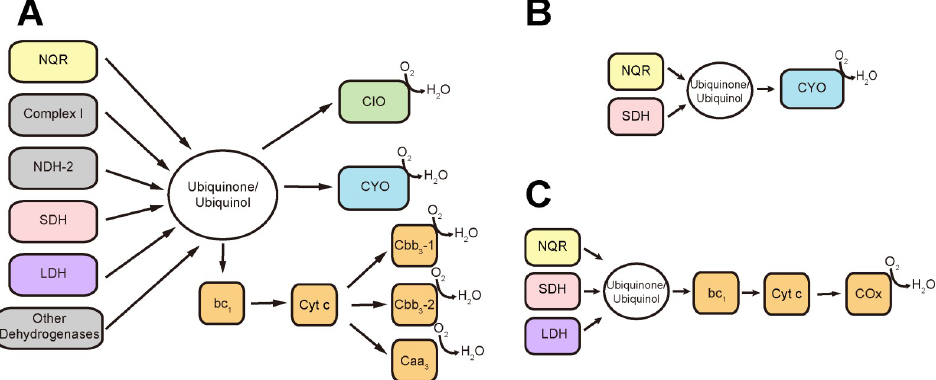
Fig 1. P . aeruginosa aerobic respiratory chain. A) Respiratory enzymes annotated in P . aeruginosa genome. Main components of the respiratory chain in LB (B) and mAUM (C)